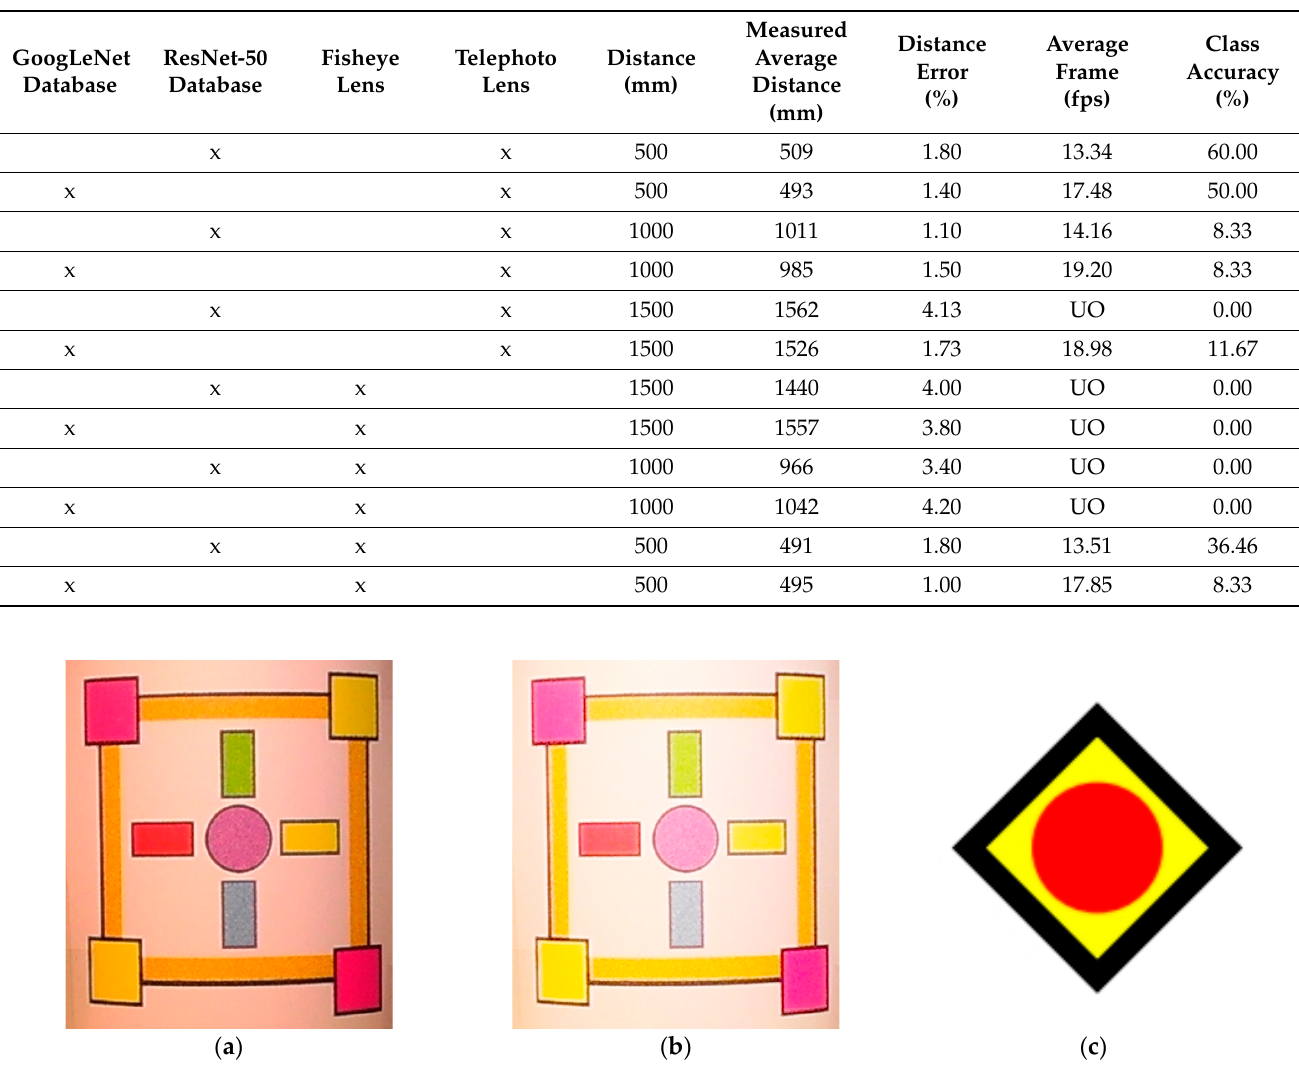
Figure 14. Reference images used for Table 2. ( a ) SET-8; ( b ) SET-11; ( c ) SET-12.